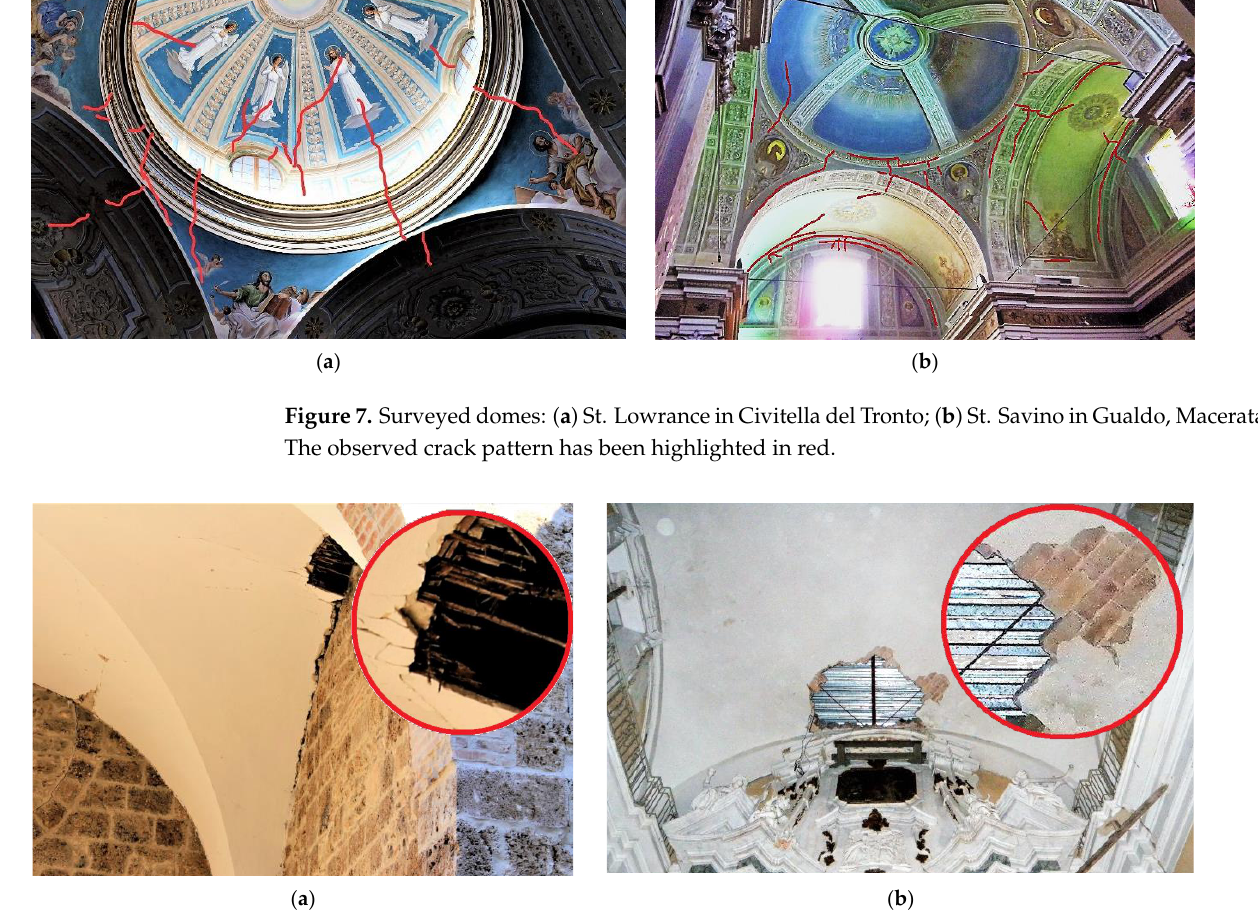
Figure 8. Surveyed vaults: ( a ) the false camorcanna vaults of Abbey of Holy Mary in Montesanto, Civitella del Tronto; ( b ) the in folio vaults of St. Anthony Abbot in Teramo.